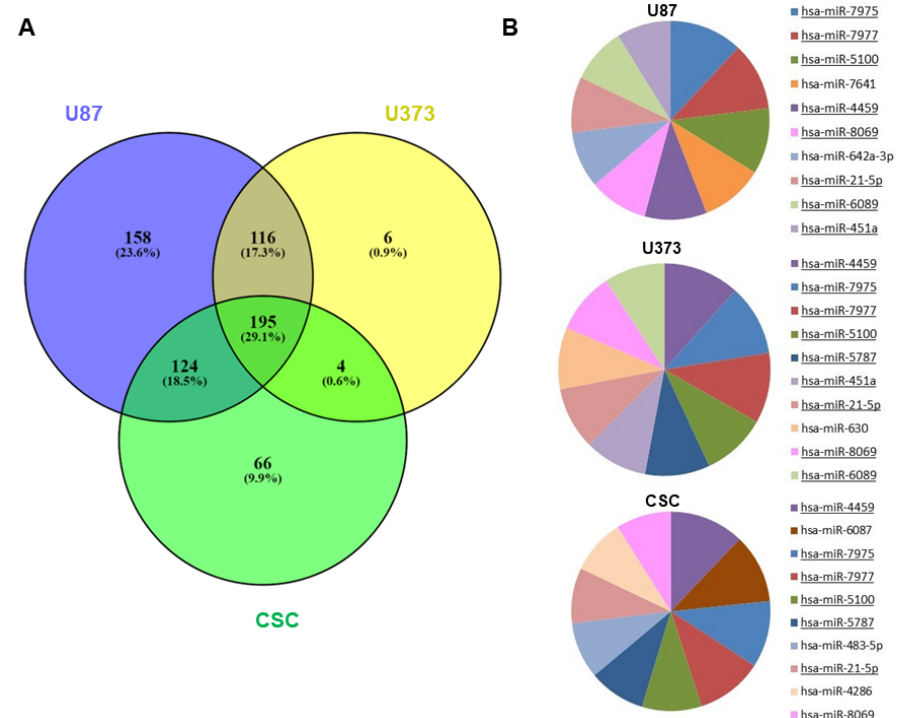
Figure 2. miRNA expression in GBM- and CSC-sEVs. ( A ) Venn diagram shows overlaps between the miRNAs expressed in sEVs secreted by U87, U373, and GBM primary CSCs. ( B ) The pie charts show the top 10 most abundant miRNAs in sEVs secreted by U87, U373, and GBM primary CSCs. MiRNAs common to two or more samples are underlined.